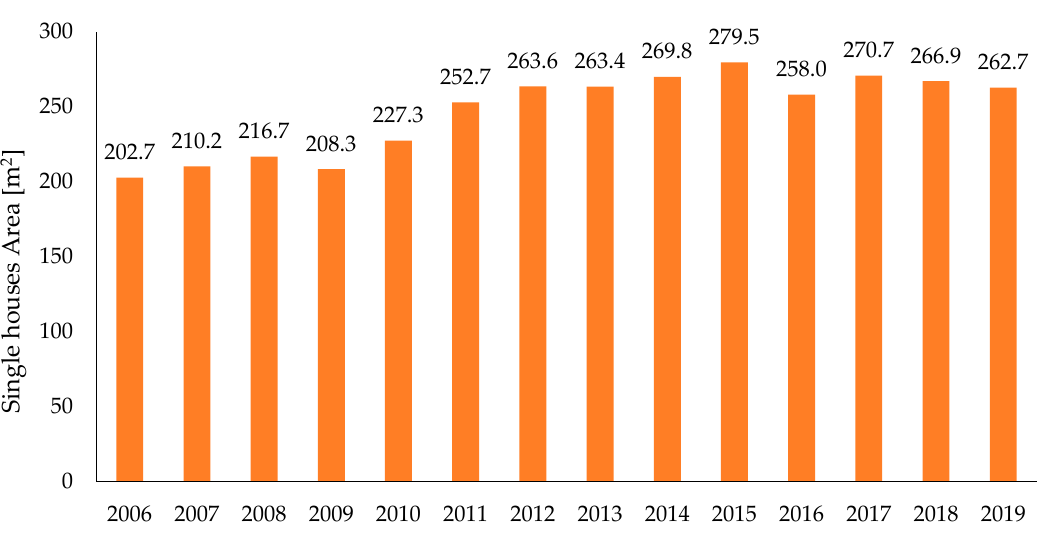
Table 2. Typical masonry and roof constructions in Cyprus, information derived from Fokaides et al. [39].